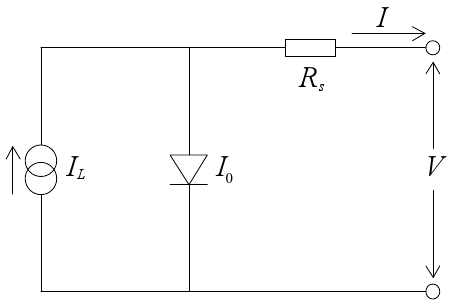
Figure 3. Four-parameter equivalent circuit for a PV panel.